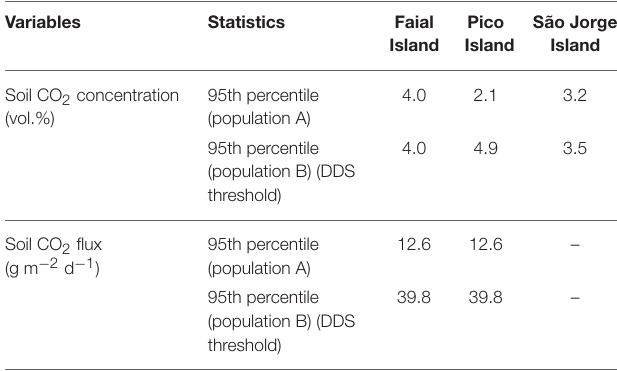
TABLE 5 | Values for the biogenic and DDS thresholds following the criteria of Sinclair (1974). Variables